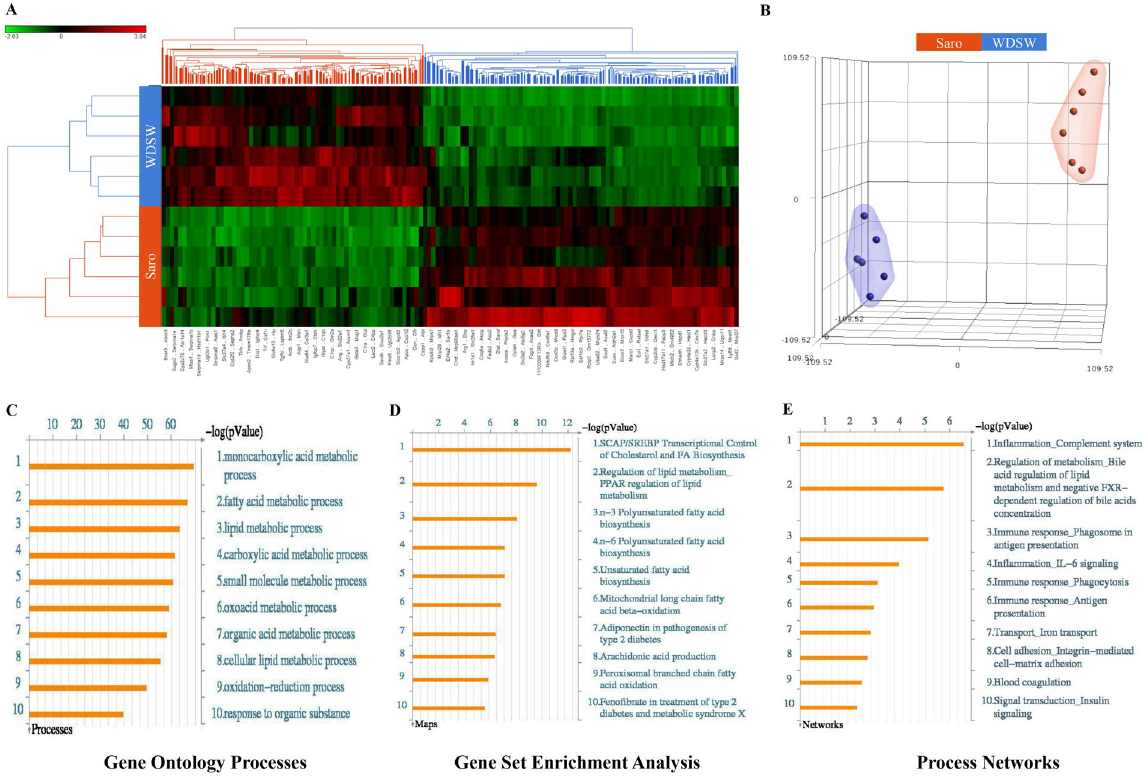
Figure 6. Hepatic gene expression data set in saroglitazar treated DIAMOND mice. Transcriptomic analysis was performed on liver tissues from saroglitazar treated mice fed with CDNW or WDSW for 12 weeks. The data are presented as ( A ) heat map demonstrating differentially expressed genes. Red and green colors indicate high and low gene expression, respectively, ( B ) t-SNE plots showing well segregated saroglitazar and WDSW groups, ( C ) Gene ontology (GO) processes; ( D ) Gene set Enrichment Analysis (GSEA); and ( E ) Process Networks analysis in saroglitazar treated mice versus untreated mice on WDSW. The top rank ordered processes, maps and networks are based on statistical